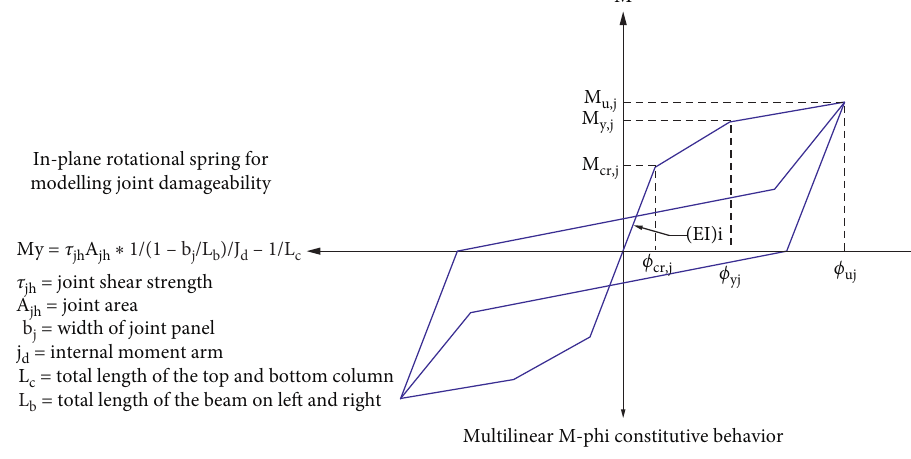
Figure 12: Joint panel shear hinge constitutive model [17].